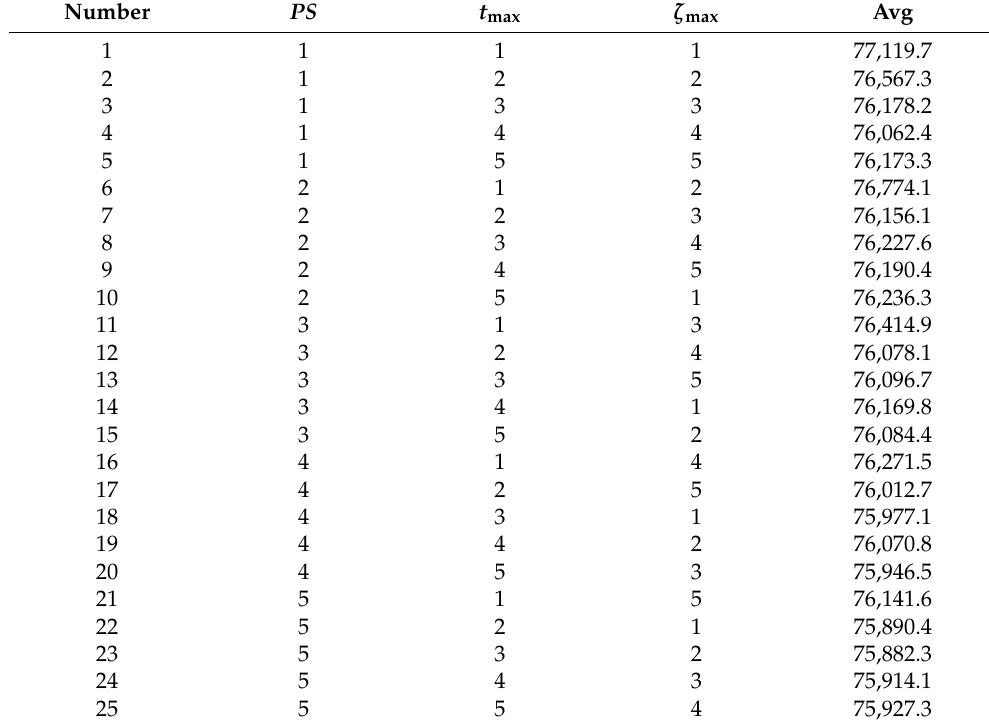
Table 2. Orthogonal array and Avg values.